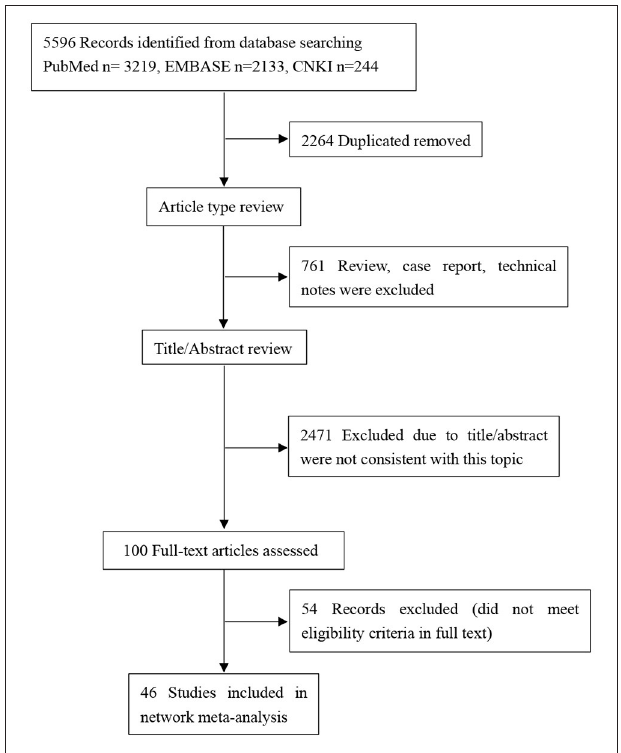
FIGURE 1 | PRISMA flow-chart showing selection of articles for network